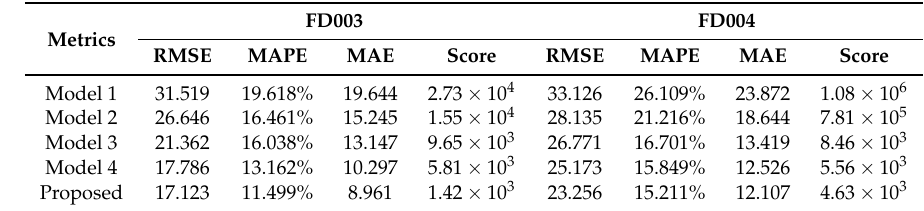
Table 3. Comparison of performance on sub-dataset (FD003) and sub-dataset (FD004).